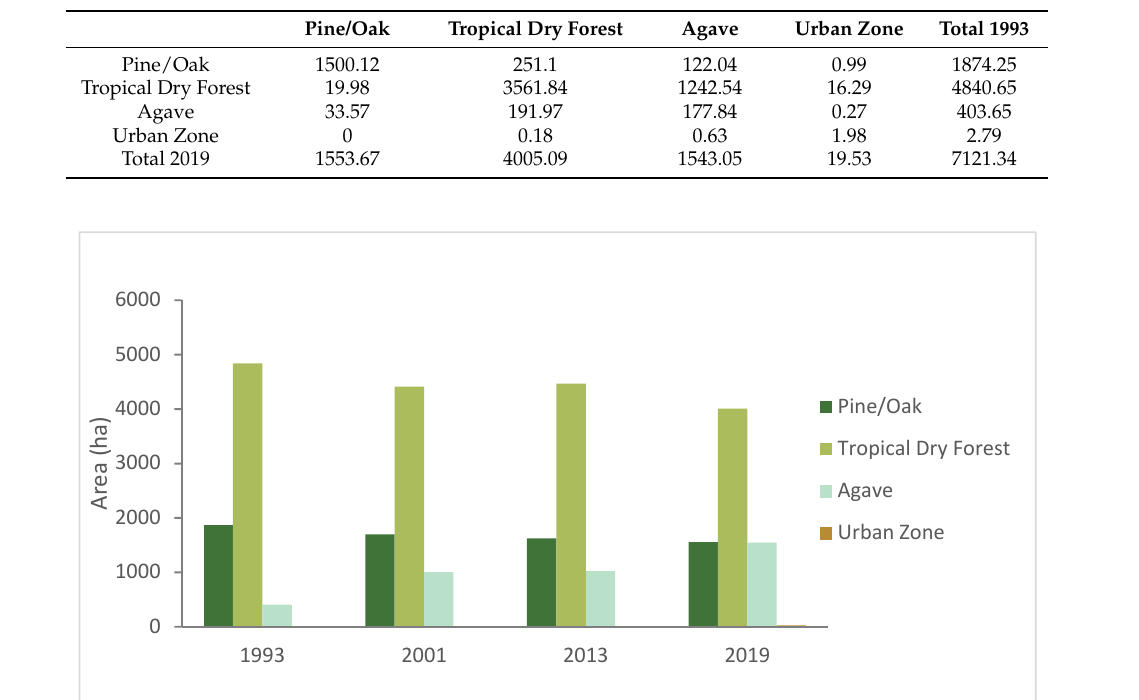
Table 4. LULC transition matrix 1993–2019 (ha).